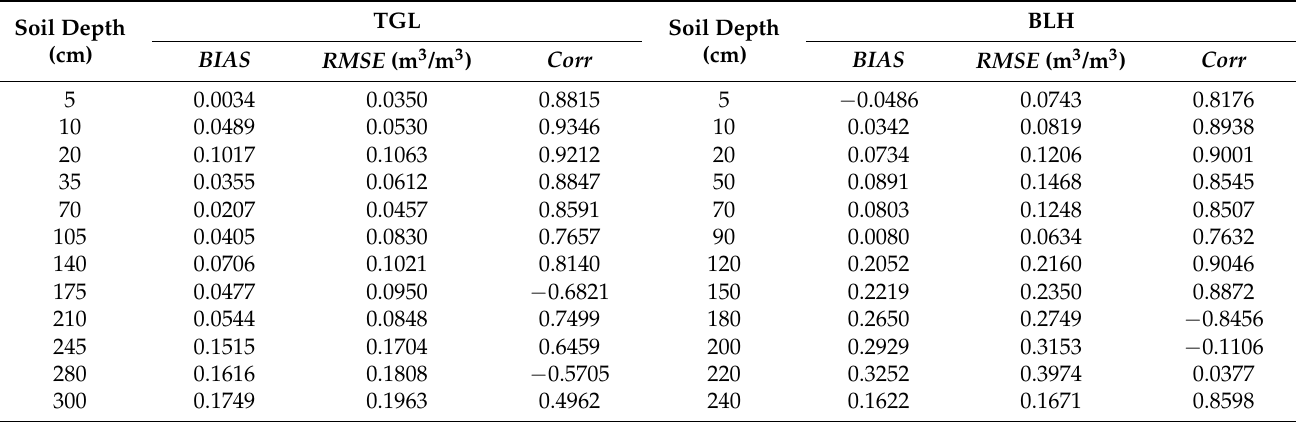
Figure 3. A comparison of the simulated and observed soil moisture at various depths at the TGL and BLH sites. Table 3. A comparative analysis of the simulated and observed soil moisture at various depths at the TGL and BLH